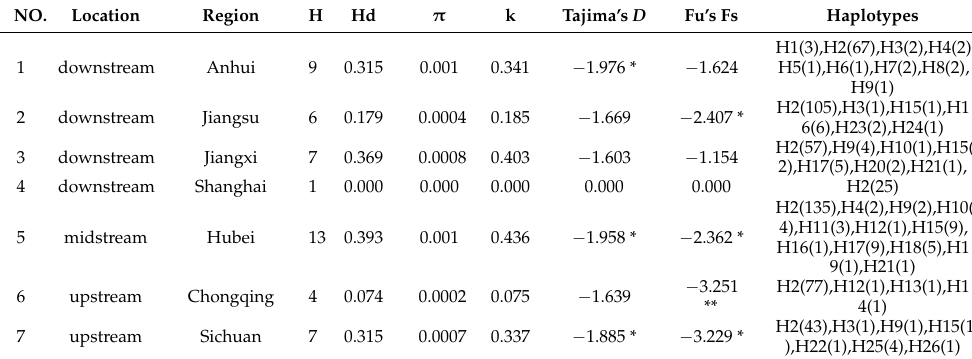
Table 5. The genetic diversity indices of all 22 Ae. albopictus populations sampled from seven locations of the Yangtze River Basin via CoxI